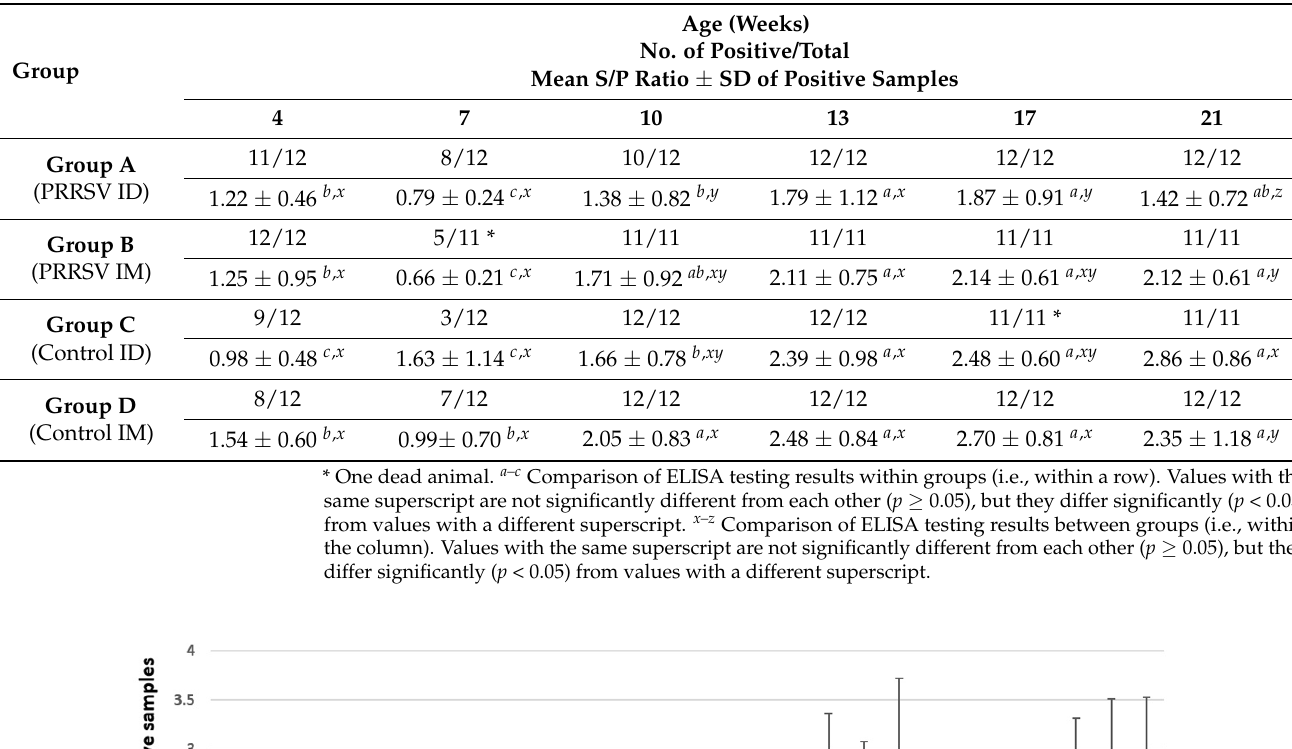
Table 2. ELISA testing results in serum samples at 4, 7, 10, 13, 17, and 21 weeks of age.